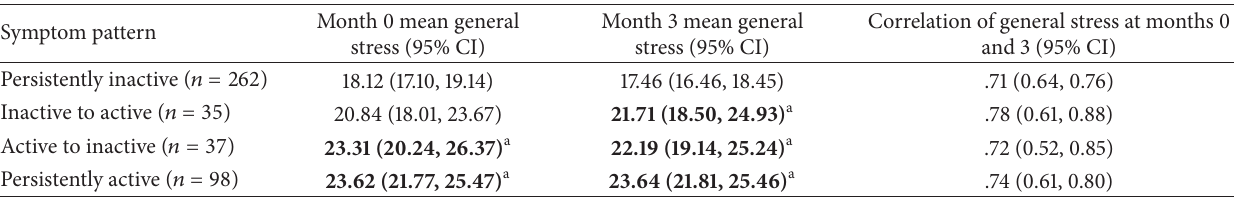
Table 1: Level of general stress (CPSS score) at month 0 and month 3 for participants with stable (inactive or active) or fluctuating (increasing or decreasing) symptom